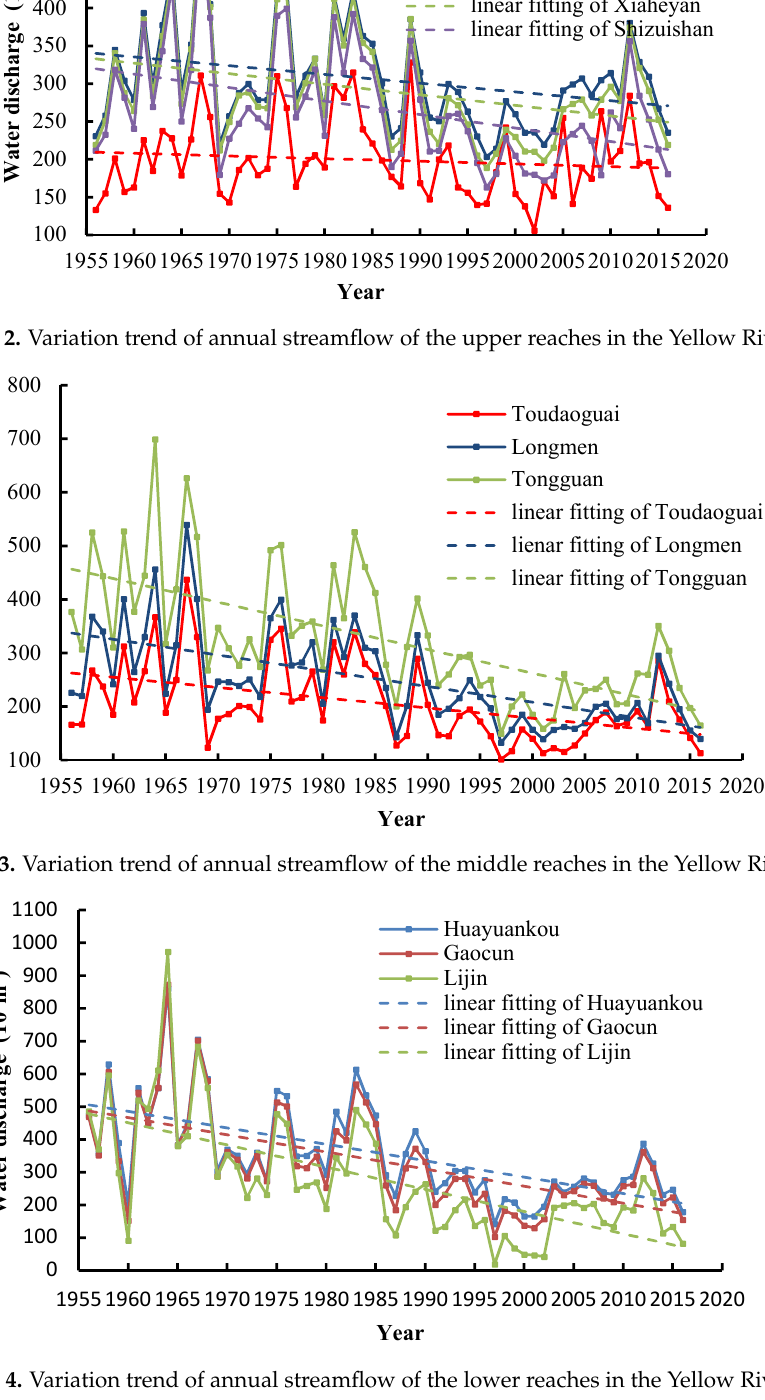
Figure 4. Variation trend of annual streamflow of the lower reaches in the Yellow River.